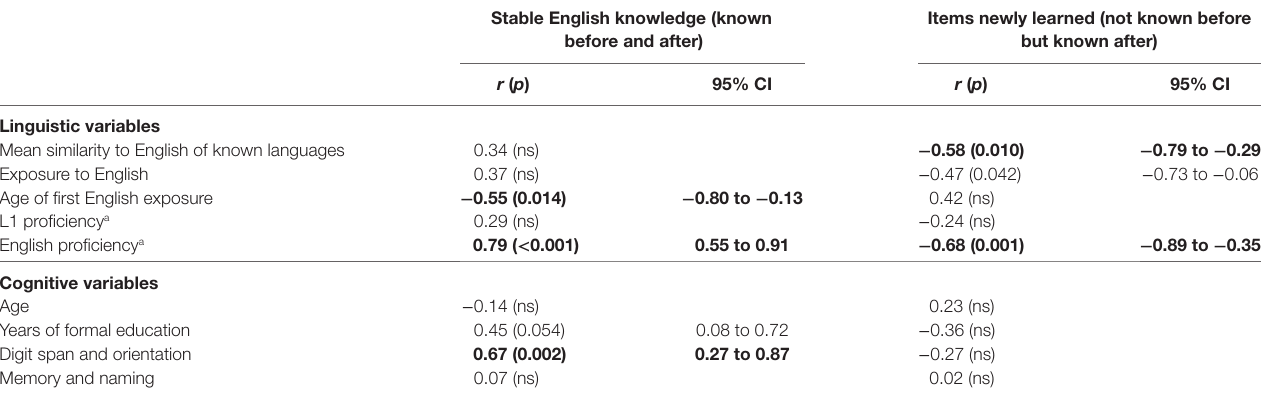
stable english knowledge (known items newly learned (not known before before and after) but known after) r ( p ) 95% ci r ( p ) 95% ci